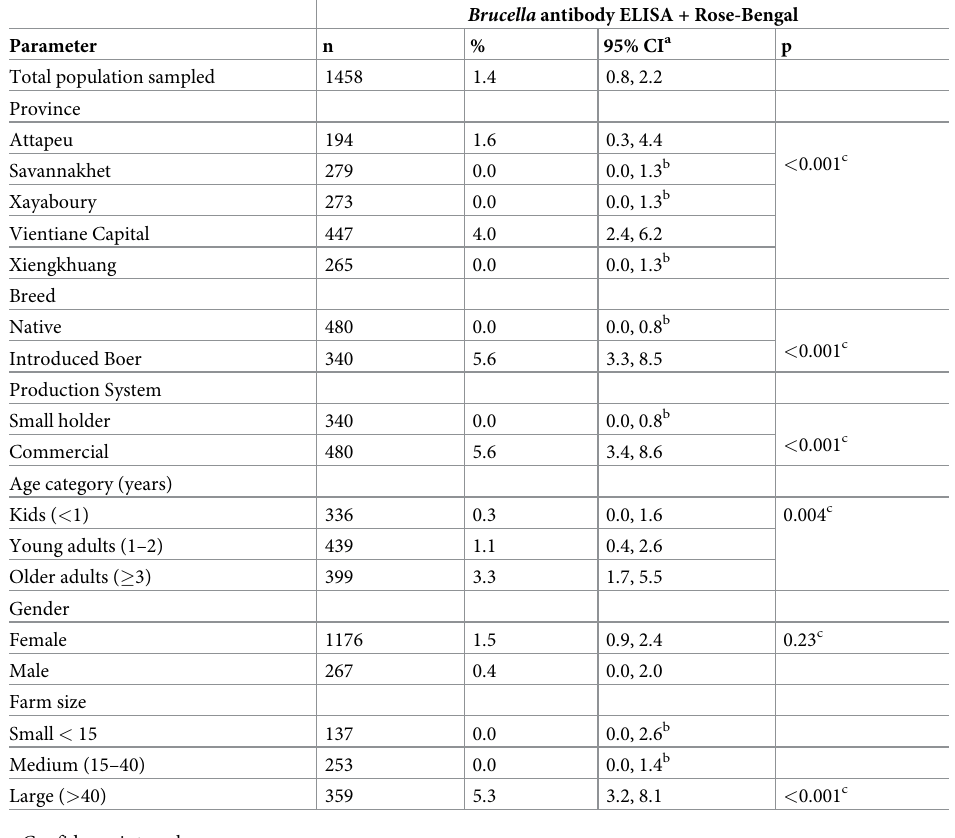
Table 4. Brucella spp. seropositivity distribution and contingency table. Brucella antibody ELISA +